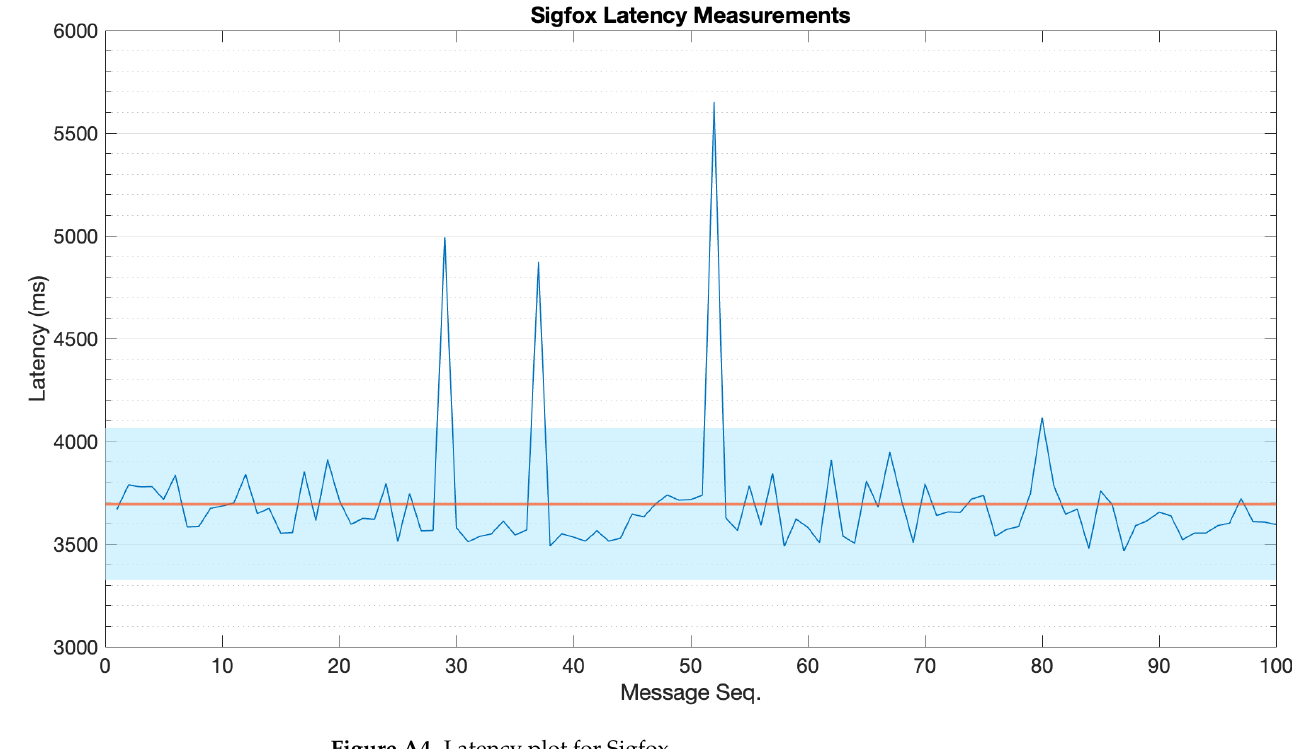
Figure A4. Latency plot for Sigfox.